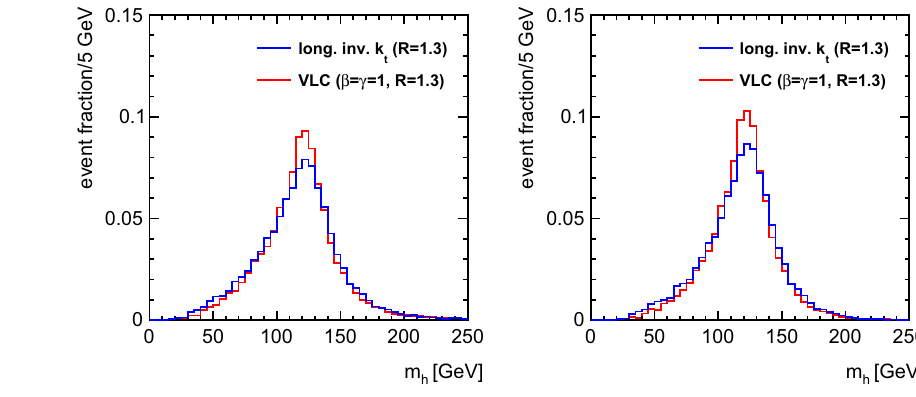
Table 2 Response and resolution of the di-jet mass distributions obtained with the k t and VLC algorithms in the left panel of Fig. 11. The columns list the median di-jet mass, the IQR 34 and the RMS